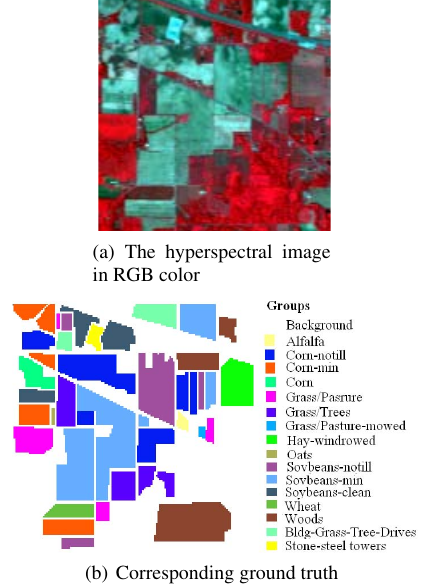
Figure 3: AVIRIS Indian Pine hyperspectral